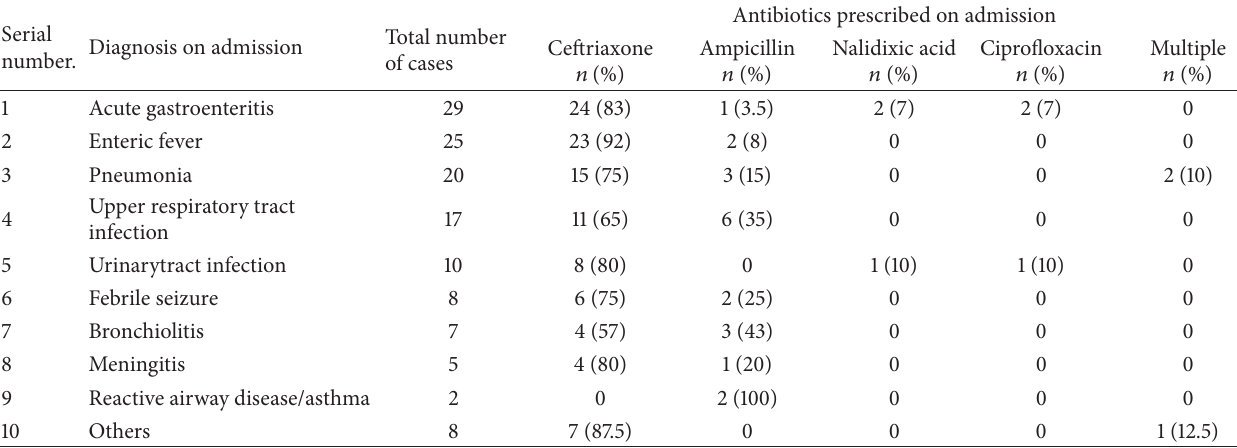
Table 1: Diagnosis and antibiotics prescribed at the time of